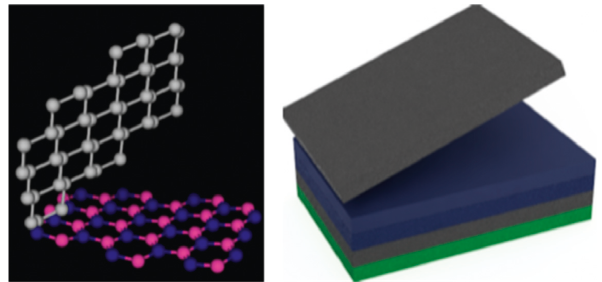
Figure 10: An example of a graphene Van der Waals structure, using blocks as analogy, adapted from [88]. Grey: graphene, purple: hBN, blue: MoS 2 , and green: WSe 2